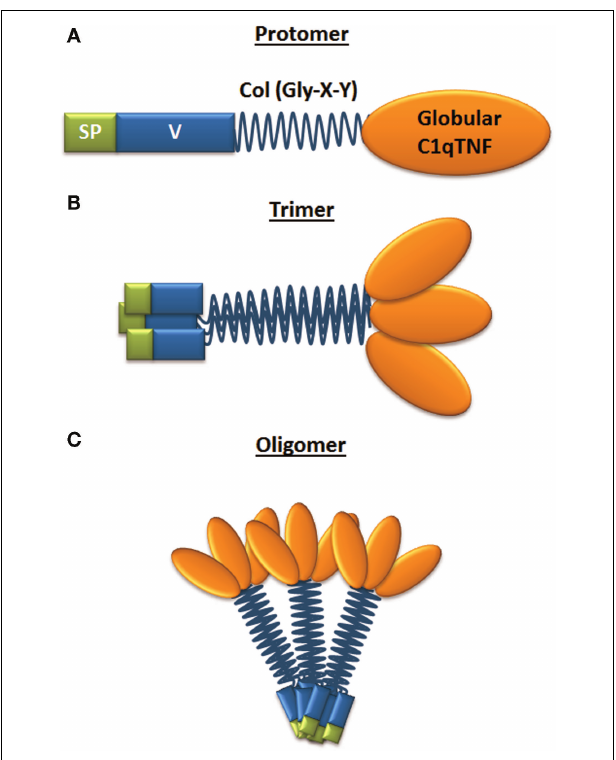
FIGURE 1 | Structure of CTRP family members . (A) Domain structure of a single CTRP protomer, which is composed of a signal peptide (SP), variable region (V), collagen domain (Col – Gly-X-Y), and globular C1q/TNF domain; (B) CTRP are secreted and can form homotrimers; (C) trimers can form higher-order multimeric 3D structures composed of multiple